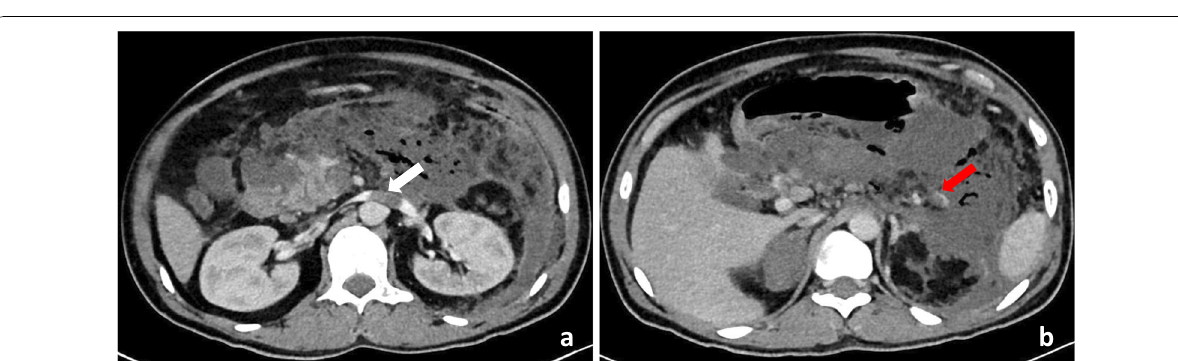
Fig. 3 CECT axial ( a ) and b images showing left renal vein thrombosis (white arrow) and splenic vein thrombosis (red arrow),